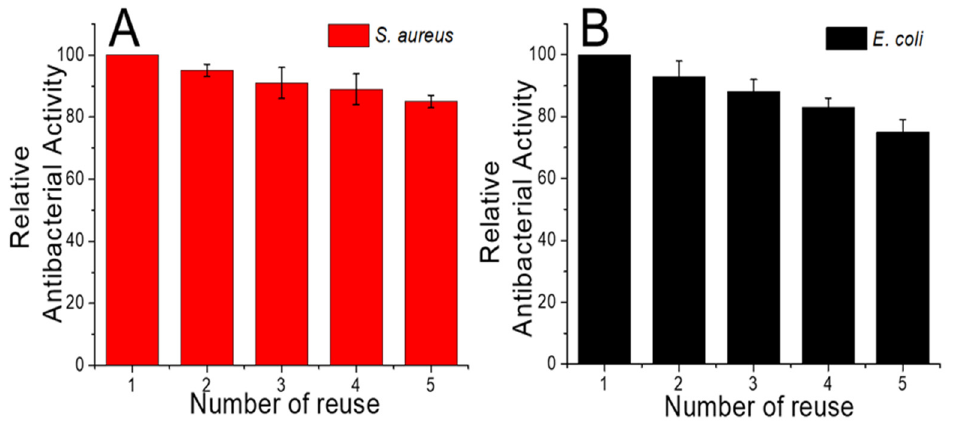
Figure 7. Reusable antibacterial effects of Ag-BSiO 2 -Fe 2 O 3 hybrid structure (200 µg mL − 1 ) on ( A ) S. aureus and ( B ) E. coli .